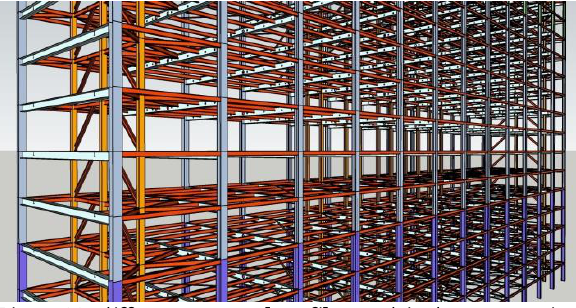
Figure 11: different structural profiles used in the construction of the ENI Office Building.